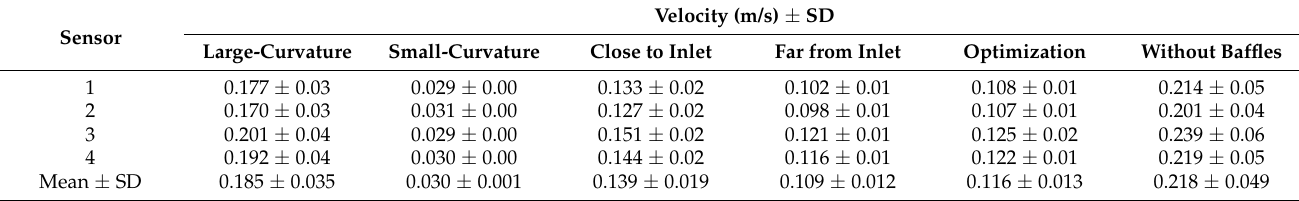
Figure 3. Simulation results of reaction chambers with different conditions. Velocity fields: ( A ). the chamber with a large-curvature; ( B ). the chamber with a small-curvature; ( C ). a baffle close to the inlet; ( D ). a baffle far from the inlet; ( E ). the chamber with an optimized baffle; ( F ). the non-baffle chamber baffle. Particle distribution: ( G ). the chamber with a large-curvature; ( H ). the chamber with a small-curvature; ( I ). a baffle close to the inlet; ( J ). a baffle far from the inlet; ( K ). the chamber with an optimized baffle; ( L ). the non-baffle chamber. Table 1. Velocity data of the reaction chambers under different velocity fields.